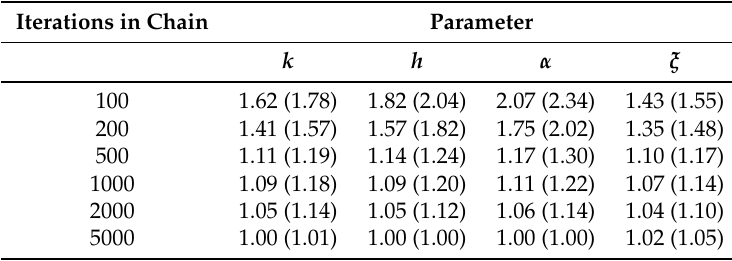
Table 3. The point estimates of the potential scale reduction factors (PSRF) and the upper bounds of its 95% confidence intervals by iterations in the Markov chains for each parameter based on the prior P1 considered in the Section 4.2 for the annual maximum wind speed data at Udon Thani, Thailand. Iterations in